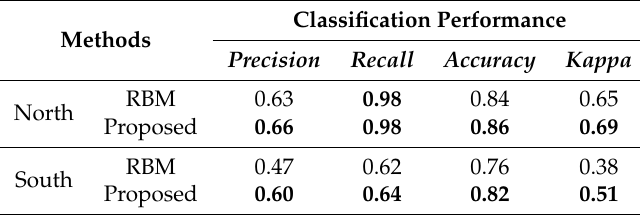
Table 3. Performance of non-trivial change detection algorithms on ASTER images. The best results in each column are in